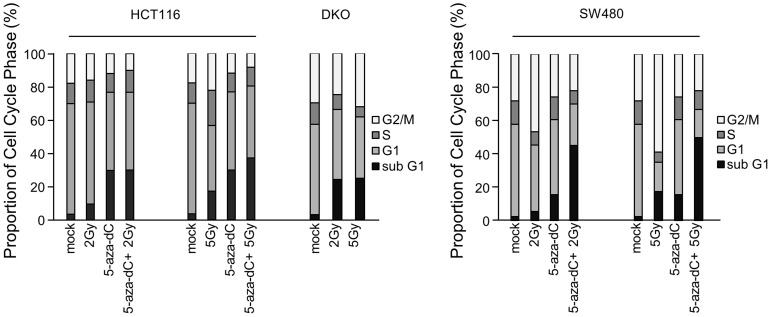
Cell cycle distributions of colon cancer cell lines in response to 5-aza-dC and irradiation exposure.Colon cancer cells (HCT116, DKO and SW480) treated with 5-aza-dC (0.5 µM) and/or irradiation (2 Gy and 5 Gy) were stained with propidium iodide and analyzed using a FACS flow cytometer. Columns show the proportion of cells in each cell cycle phase. Black column, sub-G1 phase; bright gray column, G1 phase; dark gray column, S phase; white column, G2-M phase.